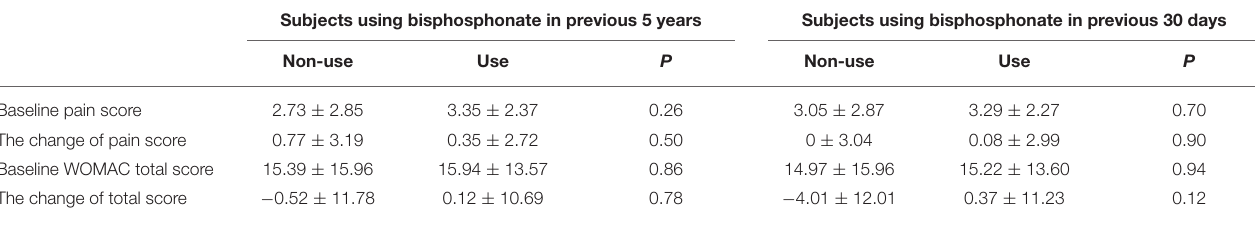
TABLE 4 | Pain score and WOMAC total score in the